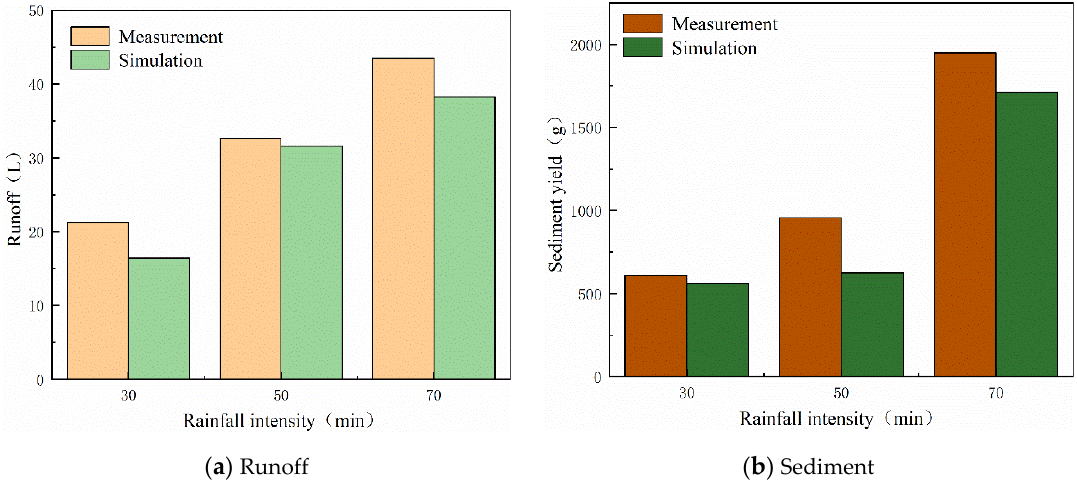
Figure 11. Total runoff and total sediment yield under different rainfall intensities.